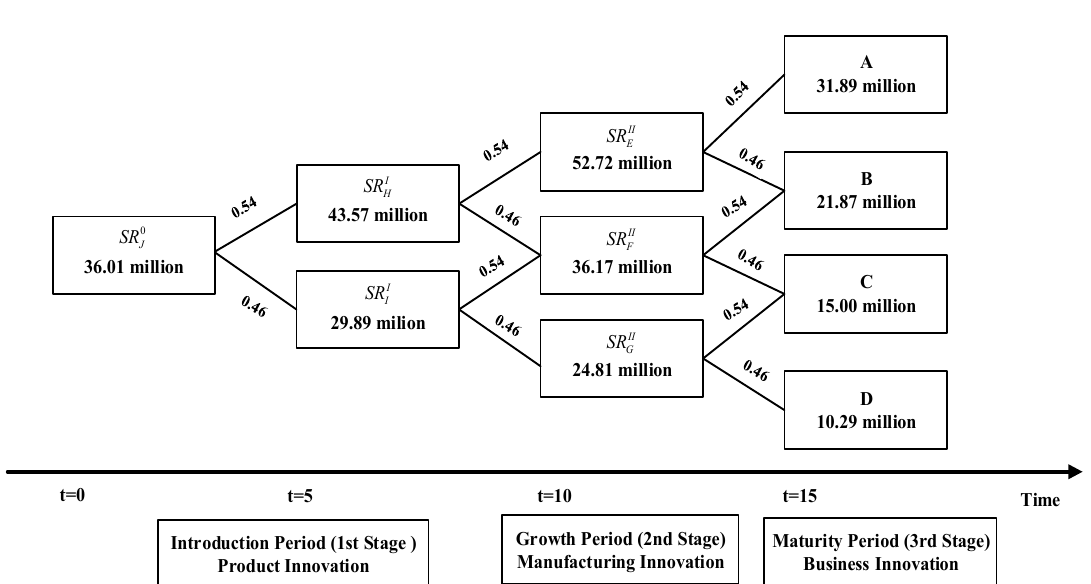
s Figure 5. Revenue SR s value of each node of compound binomial options ( r = 0.68% ). SR value of each node of compound binomial options ( 0.68% r  ). Figure 5. Revenue i i